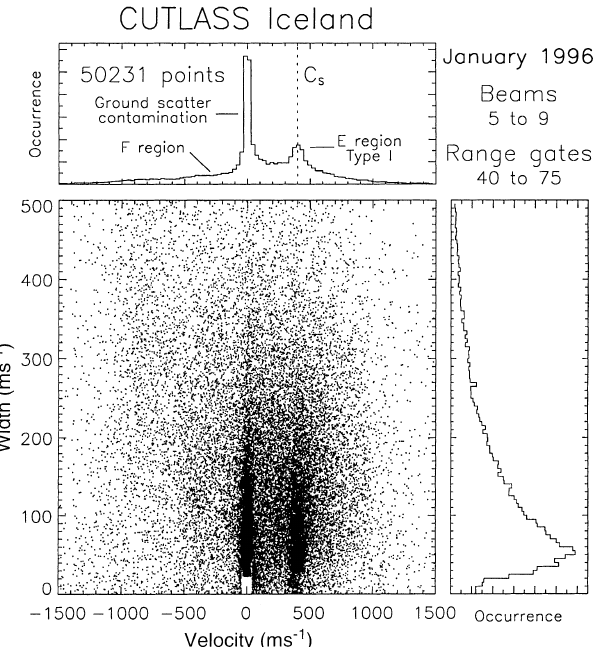
Fig. 10. A scatter plot of spectral width against Doppler velocity of backscatter observed in beams 5 to 9, range gates 40 to 75 during January 1996 by the Iceland radar. Occurrence histograms are